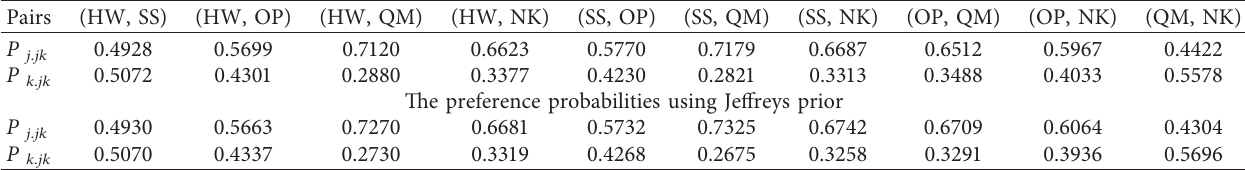
Table 4: The preference probabilities using uniform prior.